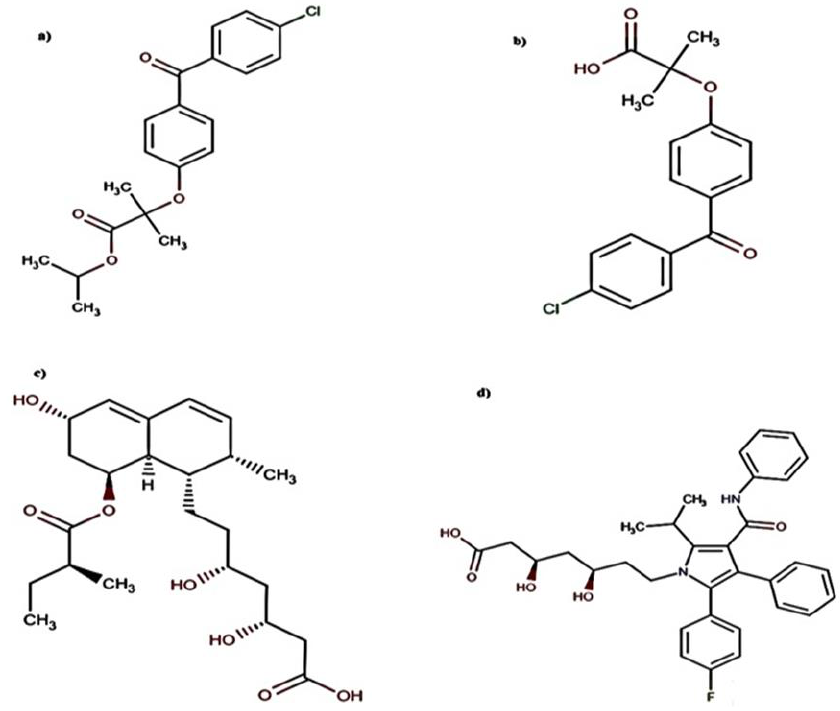
Figure 1. Chemical structures of ( a ) Fenofibrate, ( b ) Fenofibric acid, ( c ) Pravastatin sodium, and ( d ) Atorvastatin.